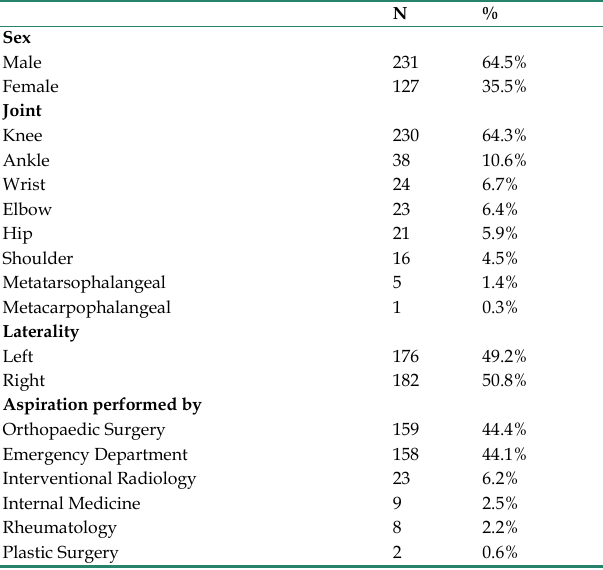
Table 1. Patient characteristics of 358 aspirations performed in 348 patients. Each aspiration was treated as a unique data point.